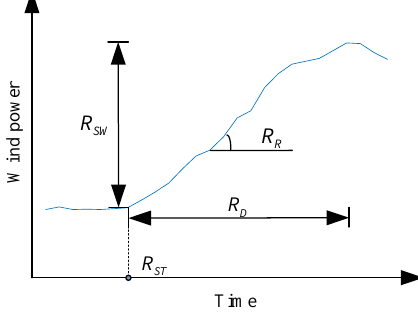
Figure 1. Features of the wind power ramp event.